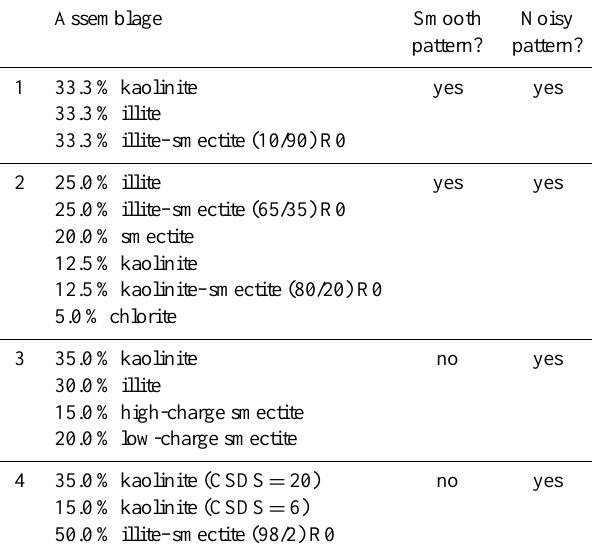
Table 4. Overview of the different test assemblages for the com- parison between multi-specimen and single-pattern refinements and the type of refined patterns. Assemblage Smooth Noisy pattern?